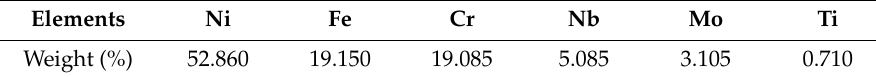
Table 2. The composition of main elements in Inconel